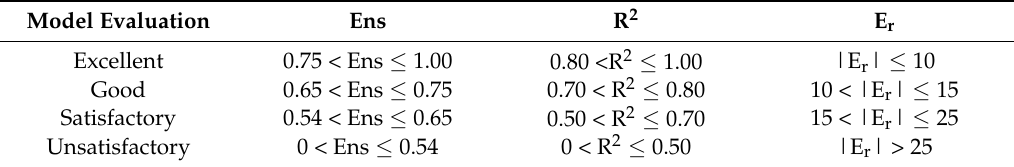
Table 3. Evaluation criteria for model performance.